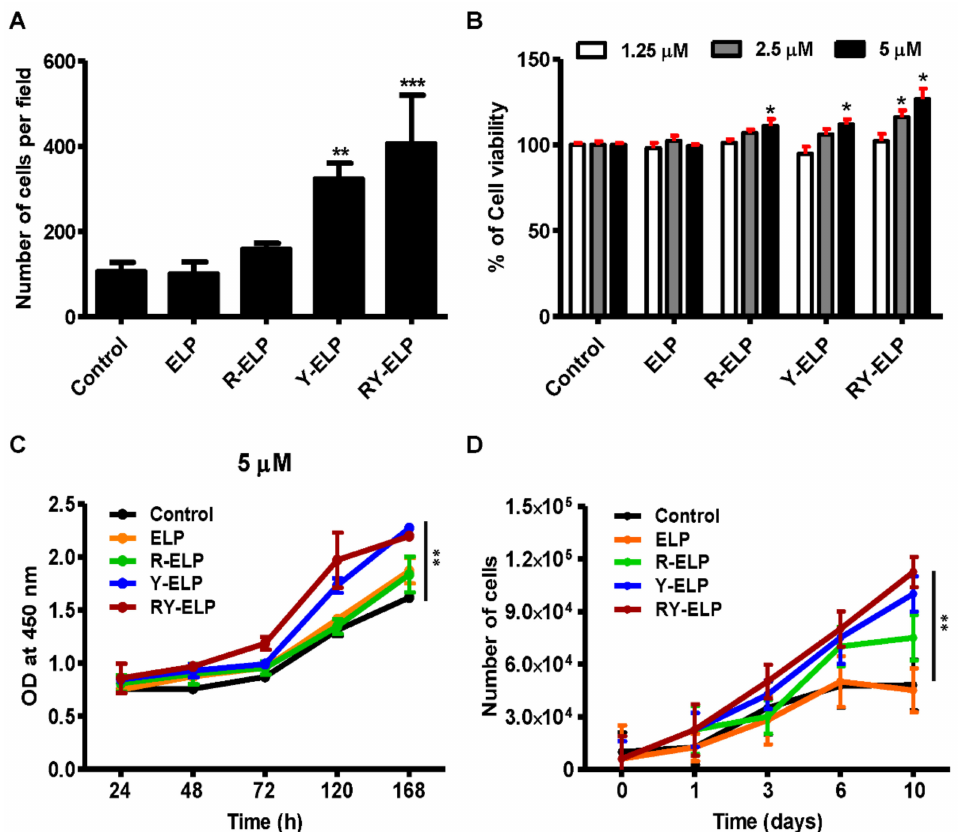
Figure 5. Cell viability and proliferation assay of MSCs. ( A ) Quantification of adhered cells observed per field ( n = 3). ** p < 0.01 and *** p < 0.001 significant difference of Y-ELP or RY-ELP compared with uncoated control. ( B ) Cell viability of MSCs was evaluated post 24 h using CCK8 ( n = 3). * p < 0.05 significant difference of fusion ELPs compared with uncoated surface. ( C ) Relative cell proliferation rates at 1, 3, 7, and 10 days were determined by CCK-8 assay ( n = 3). ** p < 0.01 significant difference RY-ELP compared with uncoated surface. ( D ) A total of 0.6 × 10 4 cells of MSCs (at P3) were seeded on 48-well plates coated with ELP variants. The effect of fusion ELP on the proliferation of MSCs was monitored by measuring the cell population at different time intervals. ** p < 0.01 significance of RY-ELP compared with untreated